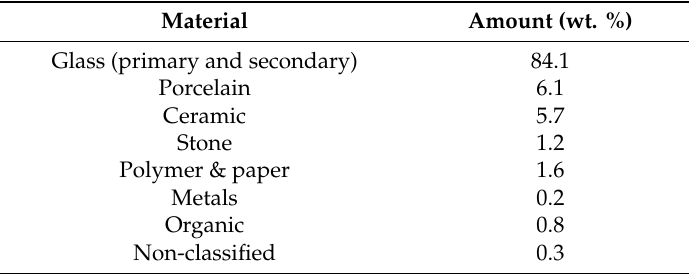
Table 3. Composition of waste glass.